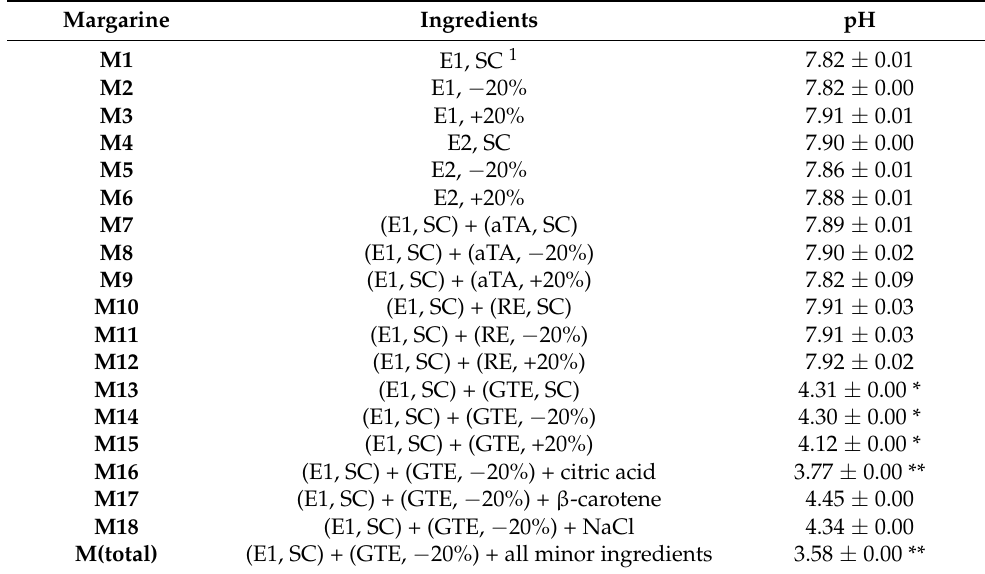
Table 2. pH-value of the different margarine samples. Data are depicted as mean ± SD (n = 4). Statistically significant differences between the margarine samples and M1 are indicated with an asterisk. Statistically significant differences between the margarine samples and M14 are indicated with two asterisks (one-way ANOVA, Holm–Sidak, p < 0.05).